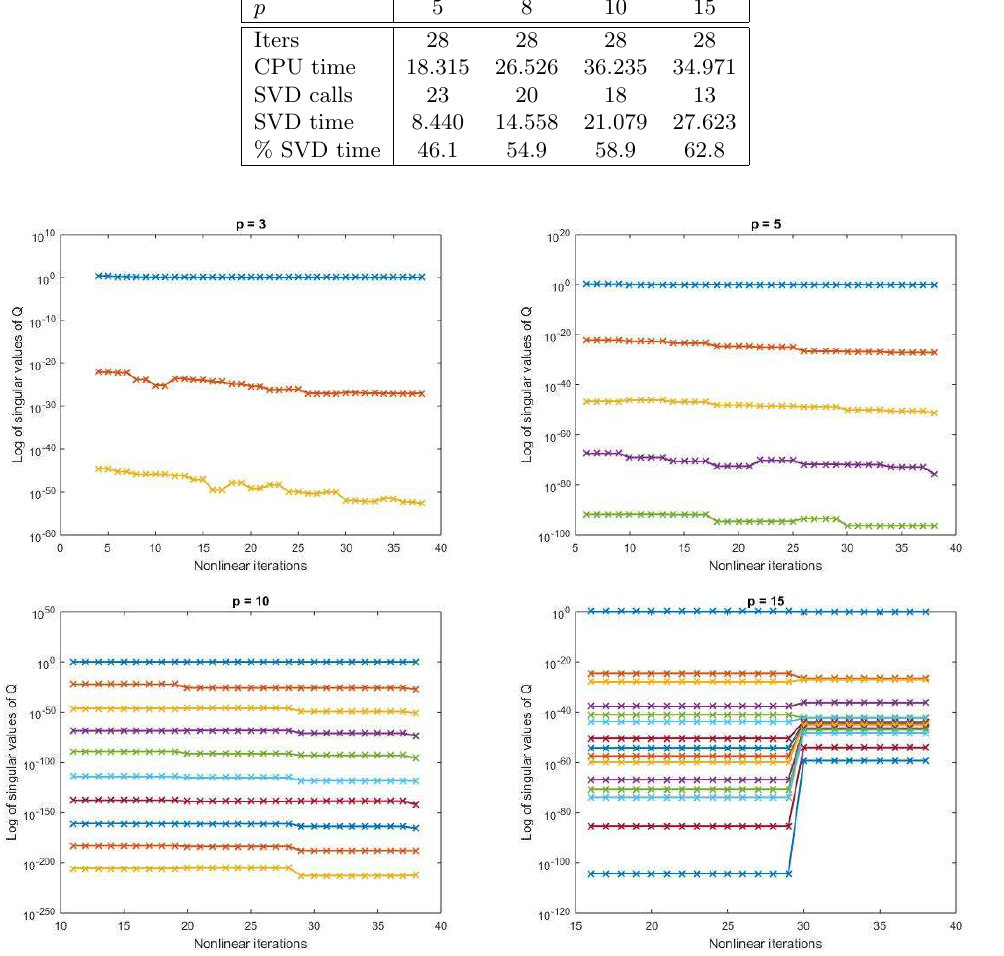
Table 2. Performance of the BRR method for Problem 1.